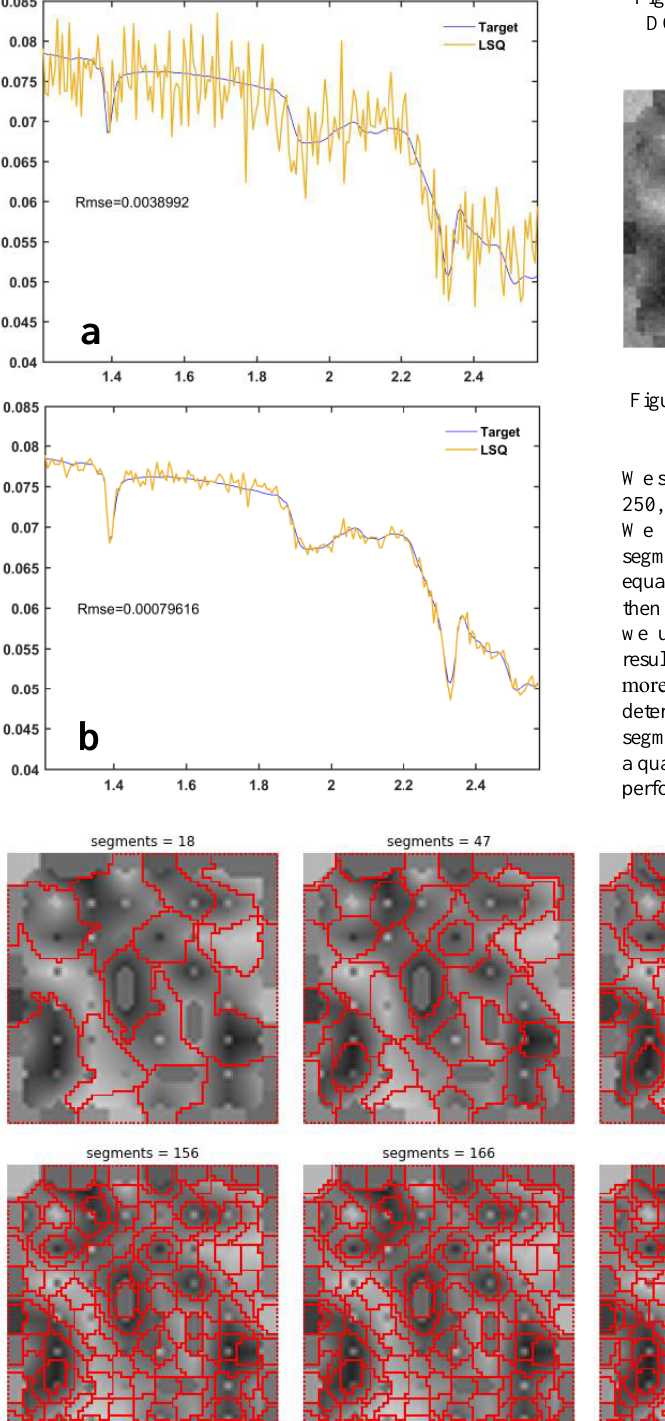
Figure 3. Spectrum reconstruction with first 4 eigenvectors of DC1(a) and DC2(b). Both data cube are contaminated with 30dB Gaussian noise.